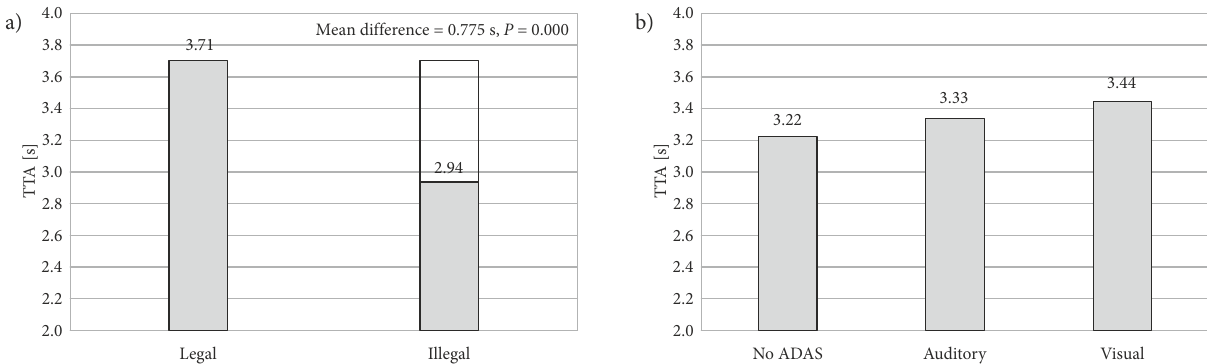
Figure 3. Effect of condition on the variable TTA: a – “crossing condition”; b – “ADAS condition